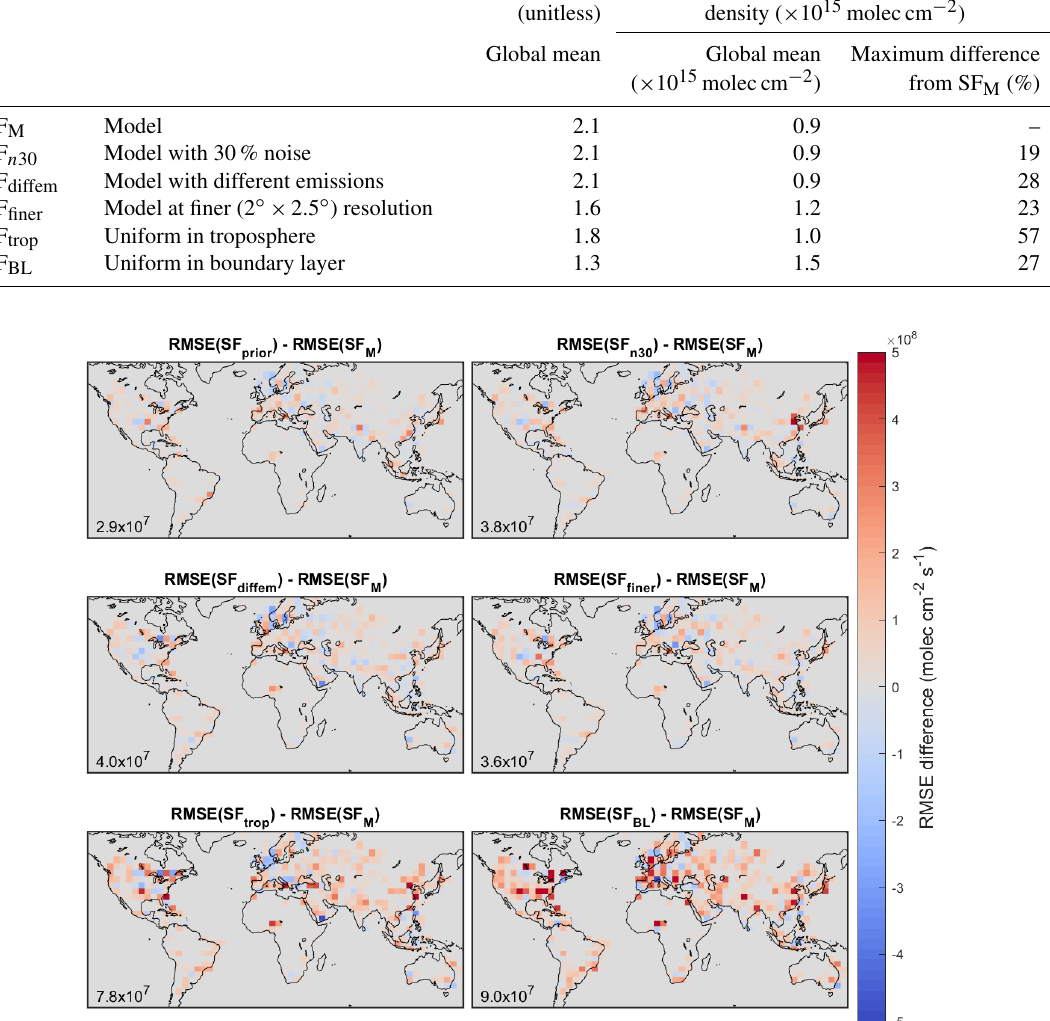
Figure 4. Difference between root mean square error (RMSE) of adjoint tests for Obs 5 synthetic observations. Root mean square differences between the a posteriori emissions estimates (moleccm − 2 s − 1 ) are